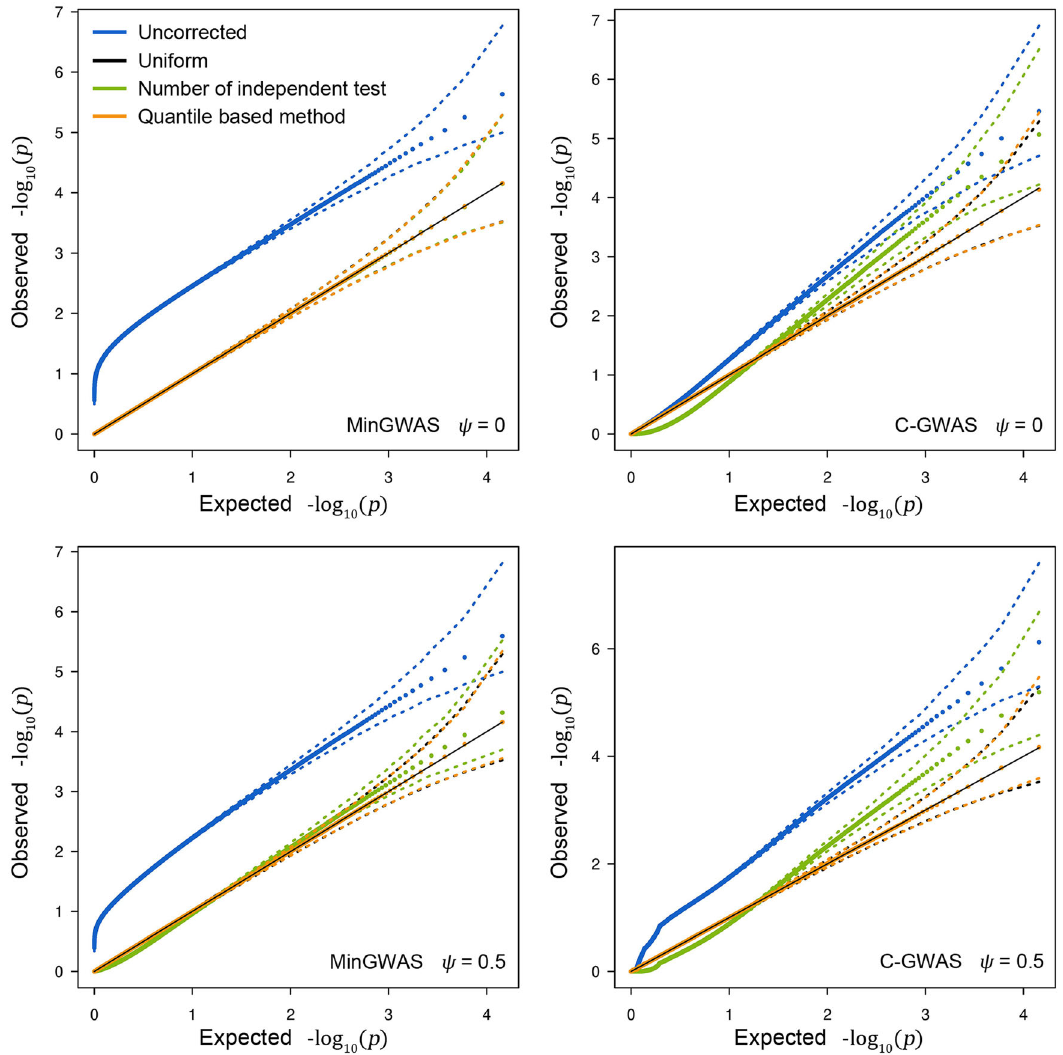
Fig. 3 | The null distributions before and after calibration from C-GWAS and MinGWAS via simulations. Vectors of T statistics and corresponding two-side p - valuesof30GWASsweresimulatedunderthenull,eachconsistingof10,000SNPs without any true effect. All pairs of T statistics vectors were simulated to have the same ψ . C-GWAS and MinGWAS were used to combine the 30 simulated GWASs. Null distributions of C-GWAS (the right column) and the MinGWAS (the left